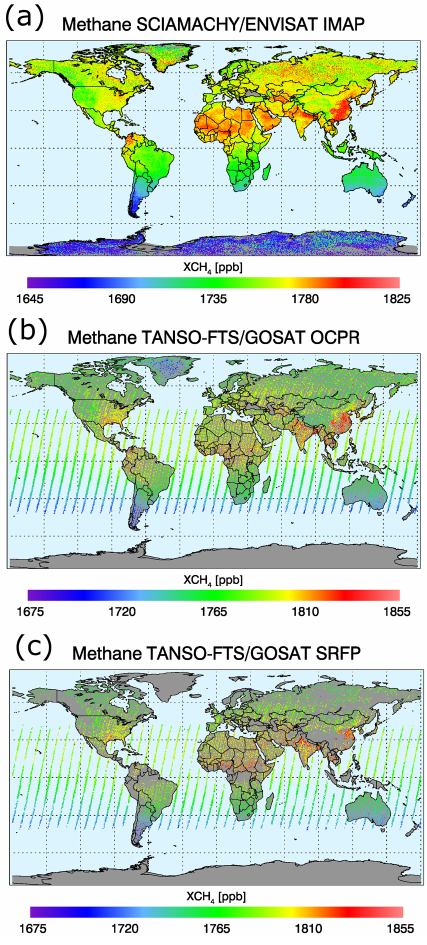
Figure 2. As Fig. 1 but for (a) SCIAMACHY IMAP X CH 4 , (b) year 2010 GOSAT OCPR X CH 4 , and (c) year 2010 GOSAT SRFP (“RemoTeC”) X CH 4 .